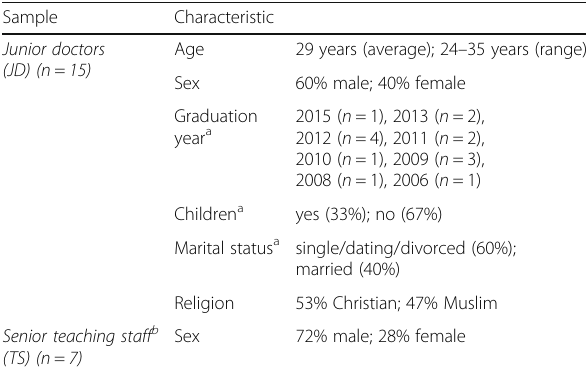
Table 2 Study participant characteristics as per November